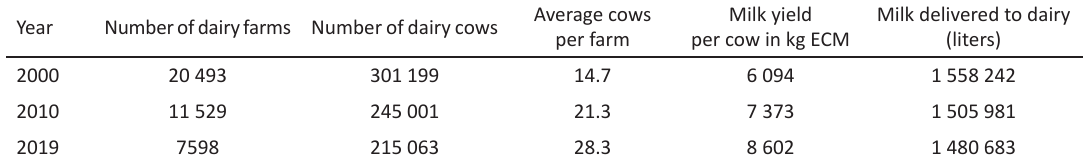
Table 1. Number of dairy farms, dairy cows, milk yield per cow and milk delivered to dairy in Norway from 2000 to 2019 (Statistics Norway 2022)